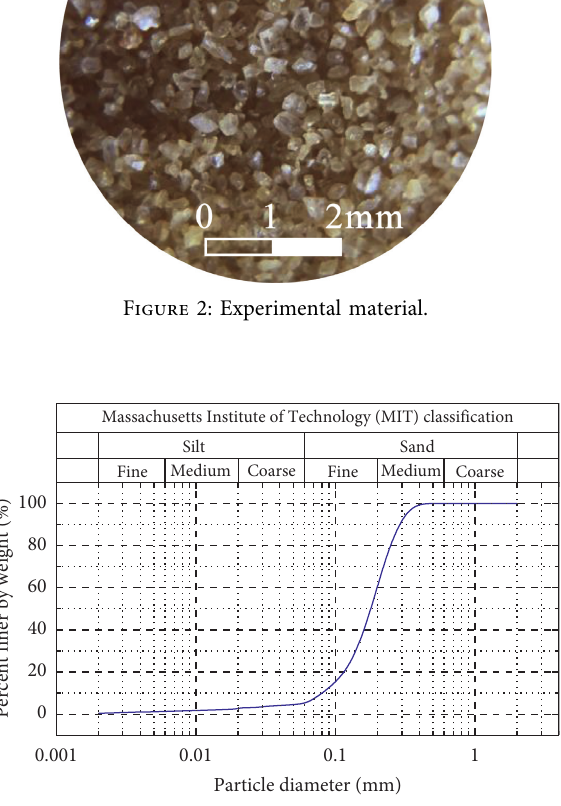
Figure 3: Particle-size distribution curve for the experimental